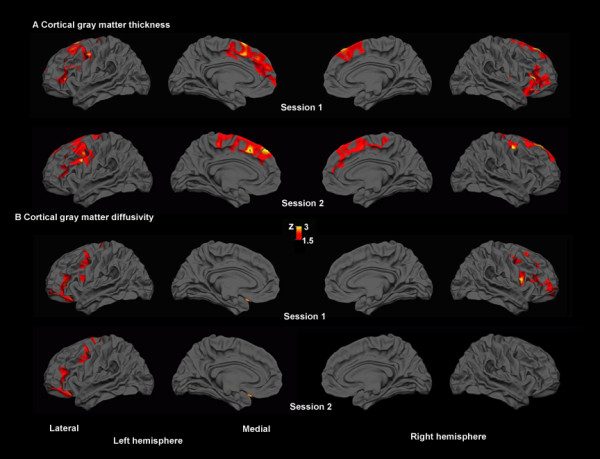
Regional cortical gray matter abnormalities detected by SBM in the TBI patient. Reduced cortical thickness (A) and increased cortical gray matter diffusivity (B) were most pronounced in the frontal lobes in two imaging sessions. Each row shows lateral and medial inflated views of the two hemispheres. Color bar shows z-values.